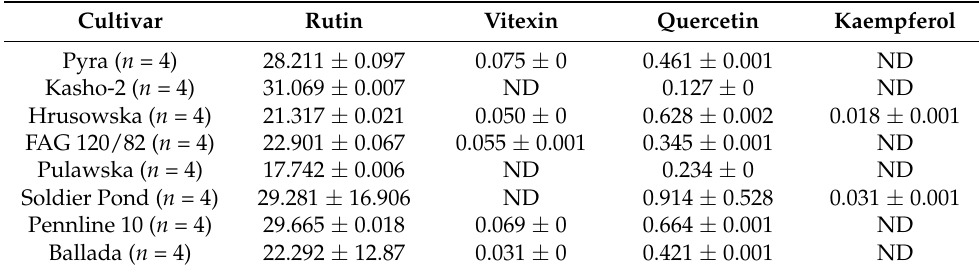
Table 2. Content of flavonoids in leaves of investigated buckwheat cultivars (mg/g d.w., means ± standard deviations of four independent